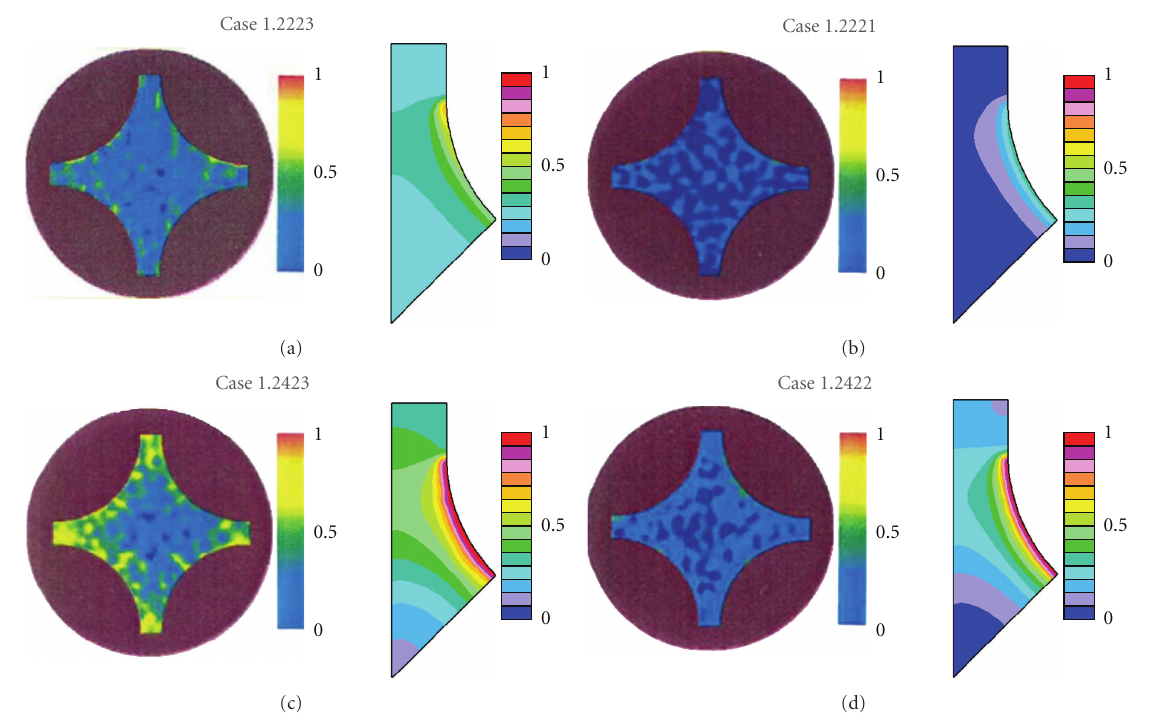
Figure 8: Void fraction distribution in a measuring section (CFD versus experimental data).